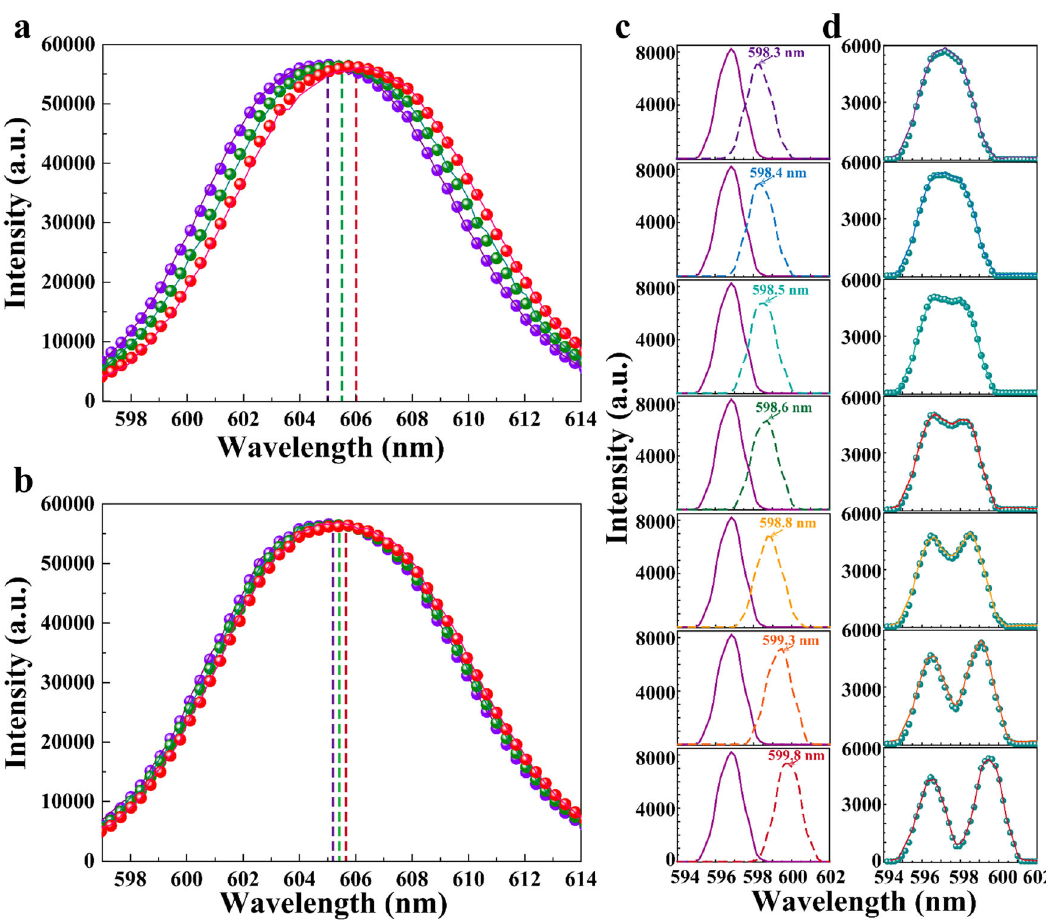
Fig. 3 | The resolution of the smart system. a , b DL-reconstructed spectra (solid lines) with a step size of 0.5nm ( a ) and 0.2nm ( b ), respectively, and the measured spectra using a conventional spectrometer (spheres). The peak positions are indi- cated by vertical dashed lines [i.e., 605.0nm (purple line), 605.5nm (green line),